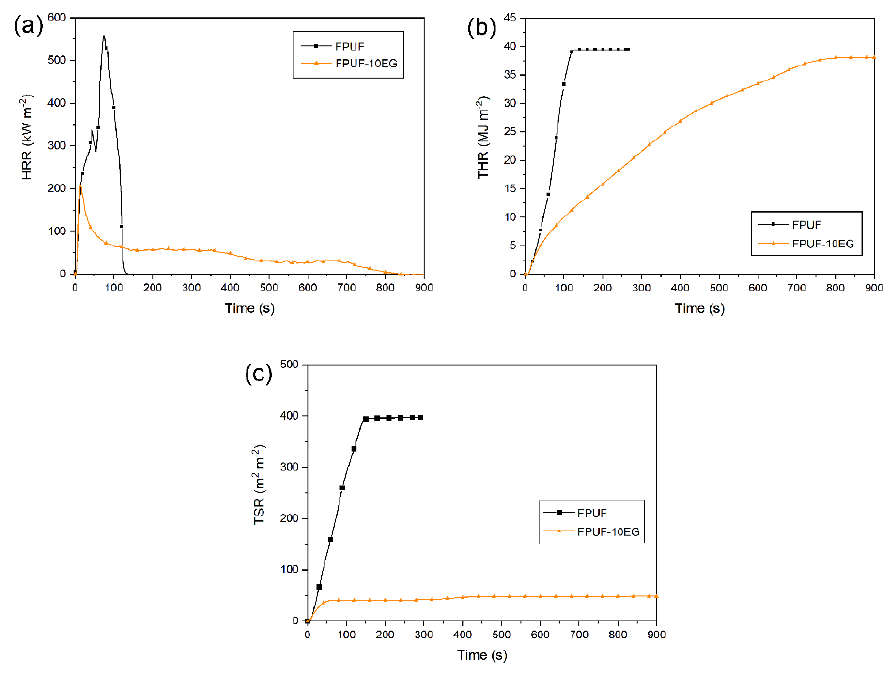
Figure 8. ( a ) Heat release rate (HRR), ( b ) total heat release (THR), and ( c ) total smoke release (TSR) of FPUFs and FPUF-10EG.